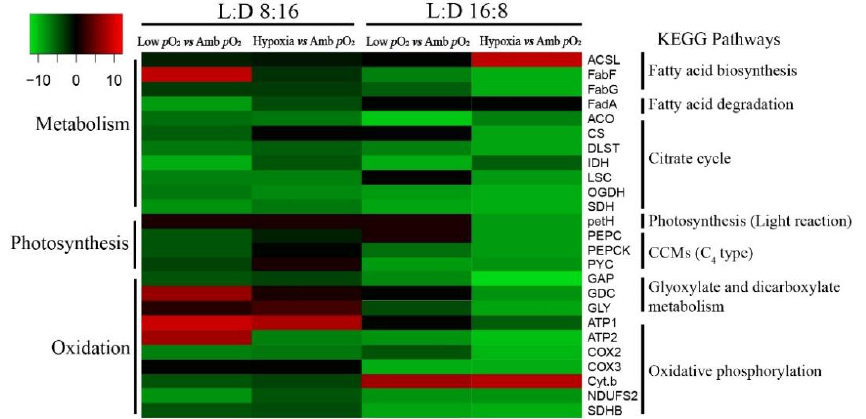
Figure 5. Heatmap of the low p O 2 or hypoxia-caused changes (|log2(Fold Change)| > 2) in the differential expressed genes (DEGs) that are related to metabolism, photosystem, oxidation, and carbon fixation of T. pseudonana grown under 8:16 and 16:8 L:D cycles. Red and green colors indicate the up- and downregulations of the DEGs, respectively. The complete gene names are shown in Table S1.